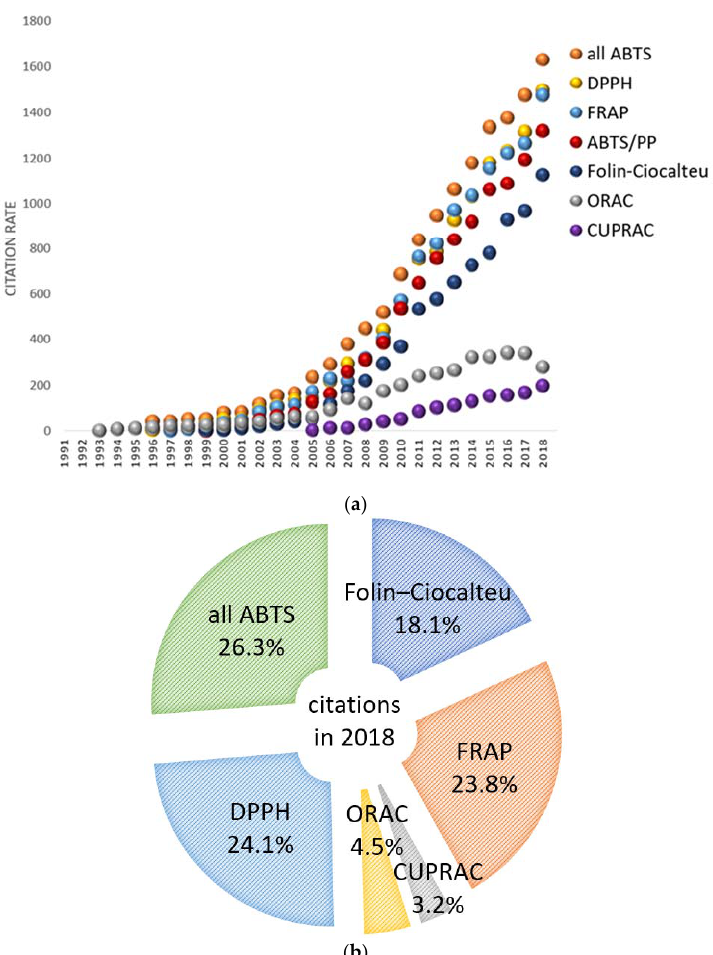
Figure 1. Citation rates of basic publications of the most widely used AOA/AOC methods from Table 1: ( a ) Dynamics of citation rates change by year. All methods showed a gradual increase of citations up to 2018, except for the oxygen radical absorbance capacity (ORAC) assays, whose citation number decreased in 2018 to the level of 2013. ( b ) Distribution of basic publications citations in 2018; the sum of these citations (6212 cites) was taken as 100%. Data are from the Scopus database.